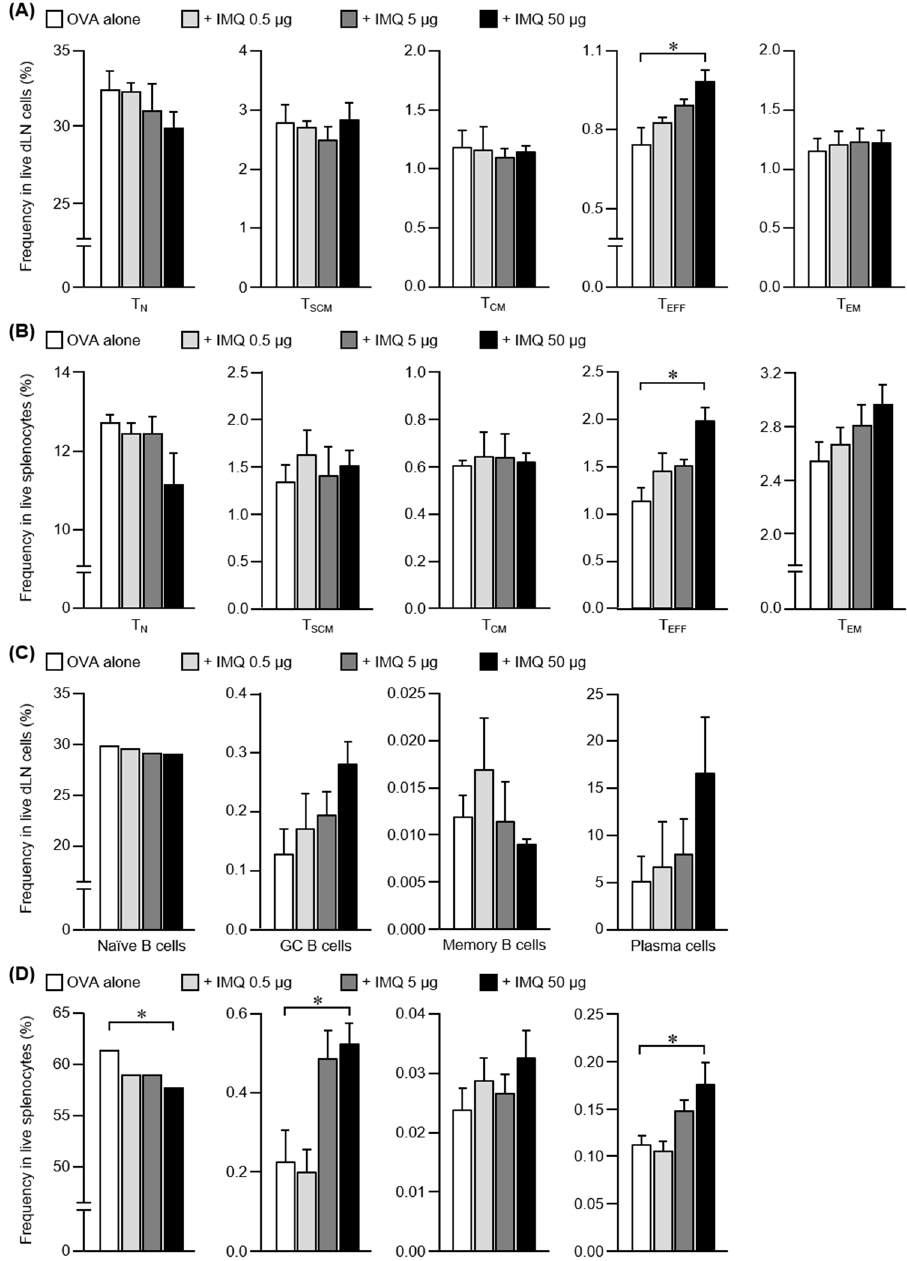
Figure 4. Differentiation of T cells and B cells after multiple immunizations with IMQ. C57BL/6 mice were immunized using the poke and patch method with OVA or OVA plus IMQ (0.5, 5, and 50 μ g) three times every 2 weeks. Two weeks after the last immunization, CD4 + T cells were divided into five subsets: T N cells, T SCM cells, T CM , T EM , and T EFF cells. B cells were divided into four subsets: naive B cells, GC B cells, memory B cells, and plasma cells. The frequency of each population in the dLNs ( A , C ) or spleen ( B , D ) was analyzed by FCM. The data shown are expressed as the mean ± SE of the results from three to four (Williams’ test, * p < 0.05, versus OVA alone).